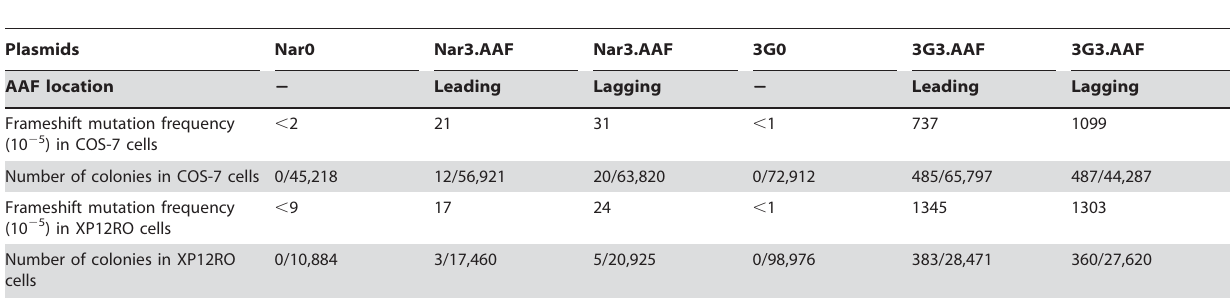
Table 1. Mutagenic TLS through AAF within the 3G sequence or the NarI site in COS-7 and XP12RO cells.